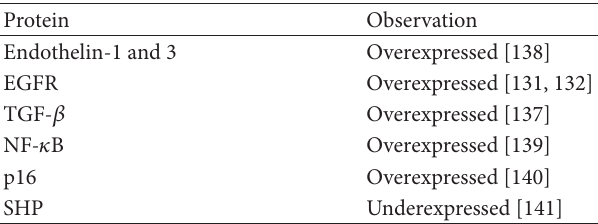
T 4: Protein expression changes in